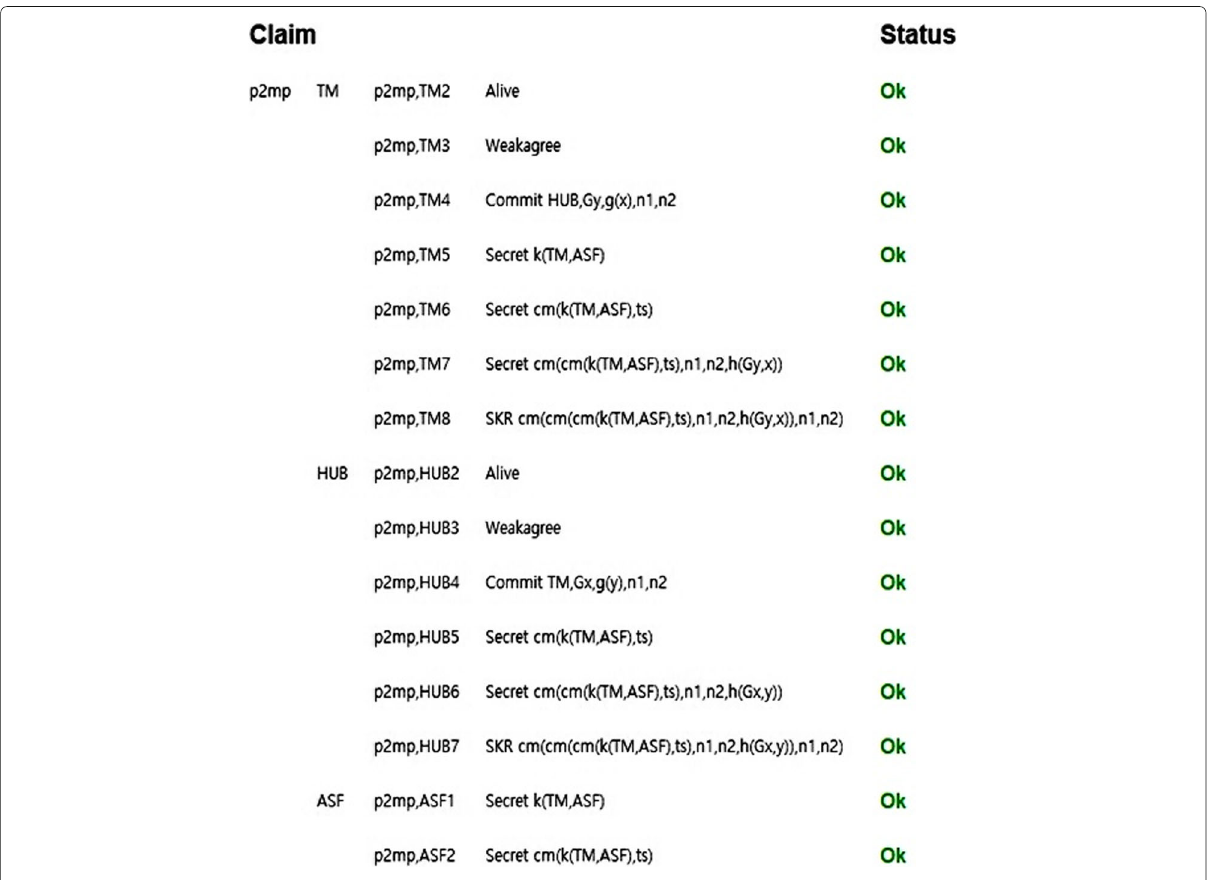
Fig. 6 Verification result of the initial